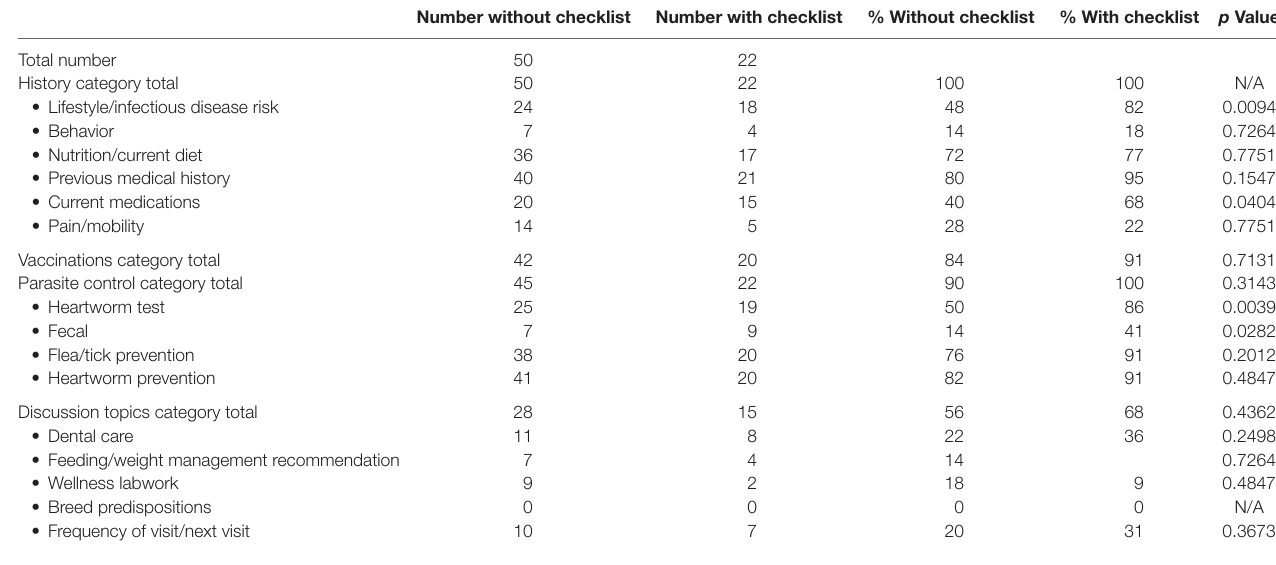
TaBle 1 | Canine visit totals, percentages, and p